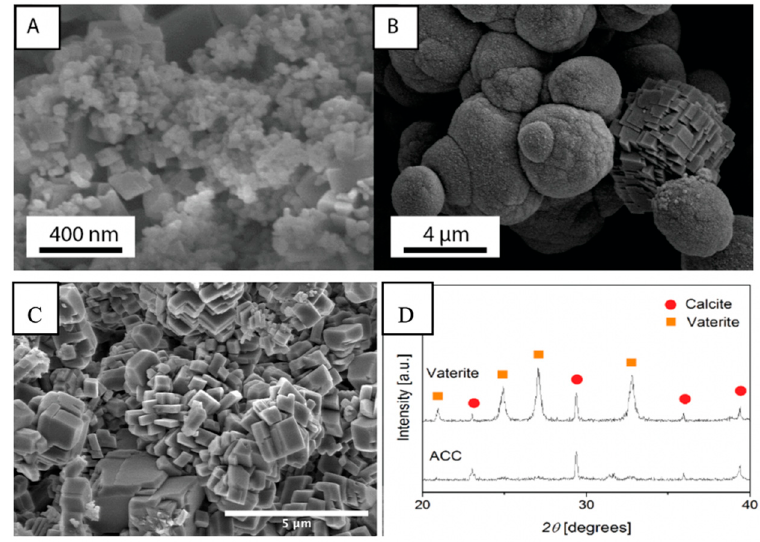
Figure 1. Scanning electron microscopy (SEM) micrographs of synthesized calcium carbonate powders in the form of ( A ) Amorphous Calcium Carbonate (ACC) phase and ( B ) vaterite phase with one calcite grain. ( C ) Calcite cement after recrystallization of ACC:V 1:3 mixture. ( D ) X-ray diffraction (XRD) patterns of lyophilized ACC and vaterite powders.